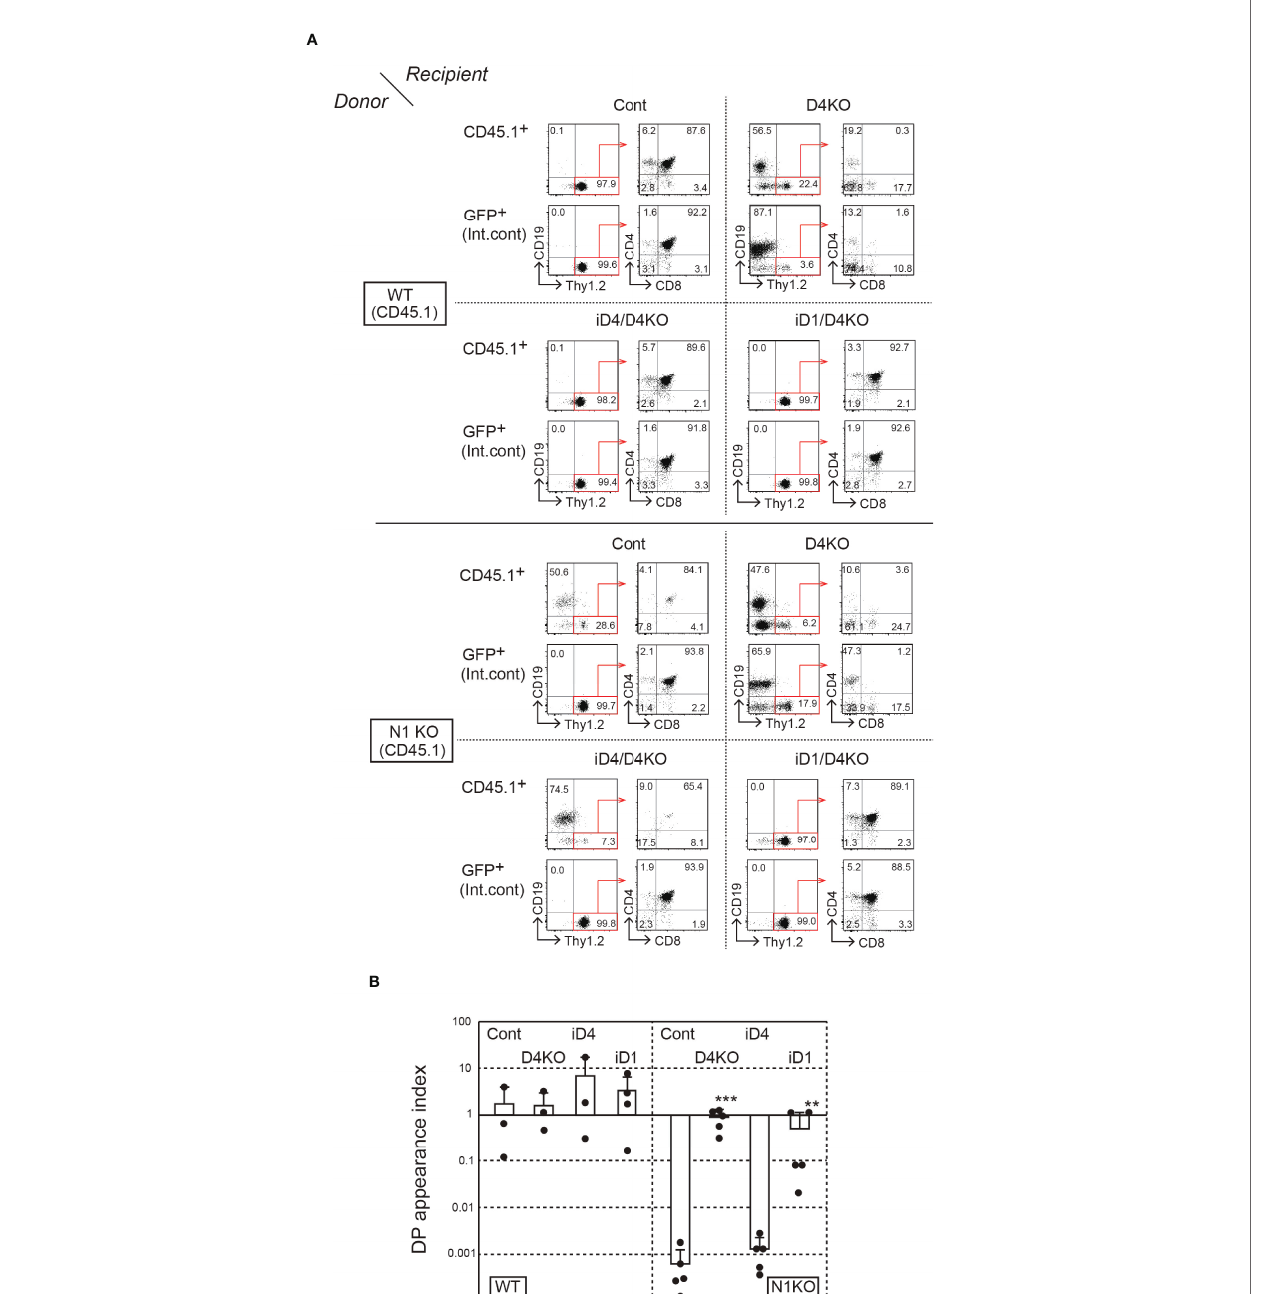
FIGURE 5 | T-cell development from Notch1 -de fi cient BM cells in the thymus of iD4 and iD1 mice. The primary BM chimeras were prepared in irradiated WT (CD45.2) mice with BM cells from Notch1 f/f (WT, CD45.1) or Rosa26 CreERT2 Notch1 f/f (N1KO, CD45.1) mice and GFP Tg mice. The control and Notch1 -de fi cient BM cells were obtained from the primary BM chimeras after the administration of tamoxifen and serially transferred into Dll4 f/f (Cont), Dll4 f/f FoxN1-Cre (D4KO), iD4 Dll4 f/f FoxN1-Cre (iD4/D4KO), or iD1 Dll4 f/f FoxN1-Cre (iD1/D4KO) mice. Four weeks after the reconstitution, thymocytes were analyzed ( Supplementary Figure 3B ). (A) Flow cytometric analysis was performed using the thymocytes from the secondary BM chimeric mice. Numbers in the pro fi les indicate the relative percentages, in CD45.1 + or GFP + cells (internal control, Int. cont) (left panels, CD19 vs. Thy1.2) and CD45.1 + Thy1.2 + or GFP + Thy1.2 + cells (right panels, CD4 vs. CD8), for each quadrant or fractions. Results represent at least three independent biological replicates. (B) The ef fi ciencies of the appearance of CD4 + CD8 + (DP) thymocytes derived from control (WT) or Notch1 -de fi cient (N1KO) BM cells were examined. DP appearance index was calculated as the ratio of CD45.1 + /GFP + DP thymocytes and CD45.1 + /GFP + B220 + B cells in lymph node (mean ± SD; WT as donor; Cont, n=3; D4KO, n=3; iD4/D4KO, n=3; iD1/D4KO, n=4; N1KO as donor; Cont, n=5; D4KO, n=5; iD4/D4KO, n=5; iD1/D4KO, n=5). The data were collected from three independent experiments. Each closed circle indicates the index in each mouse. **p < 0.01, ***p < 0.001 by Mann – Whitney U